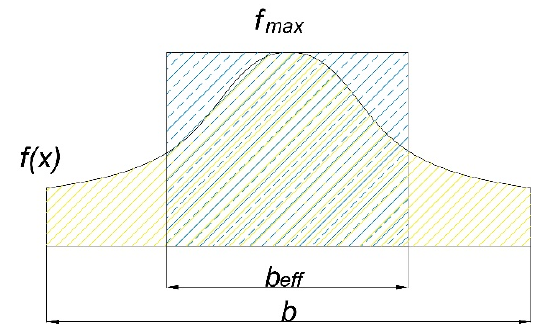
Table 2. Multiple presence factors [5].